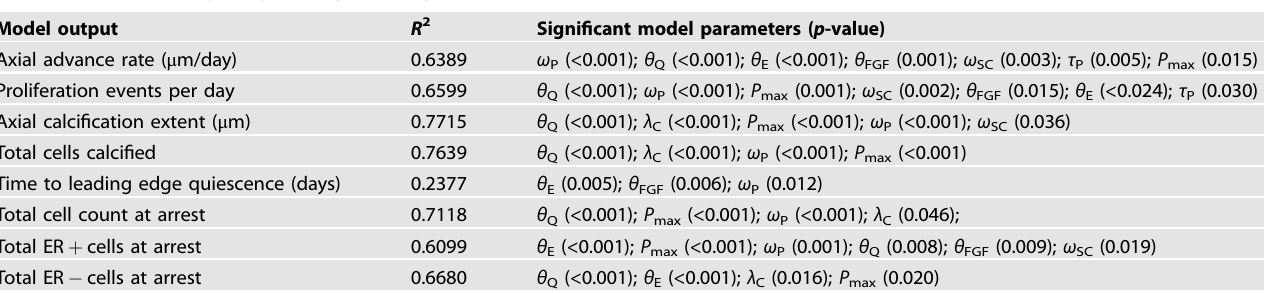
Table 2. Global sensitivity analysis using linear regression without